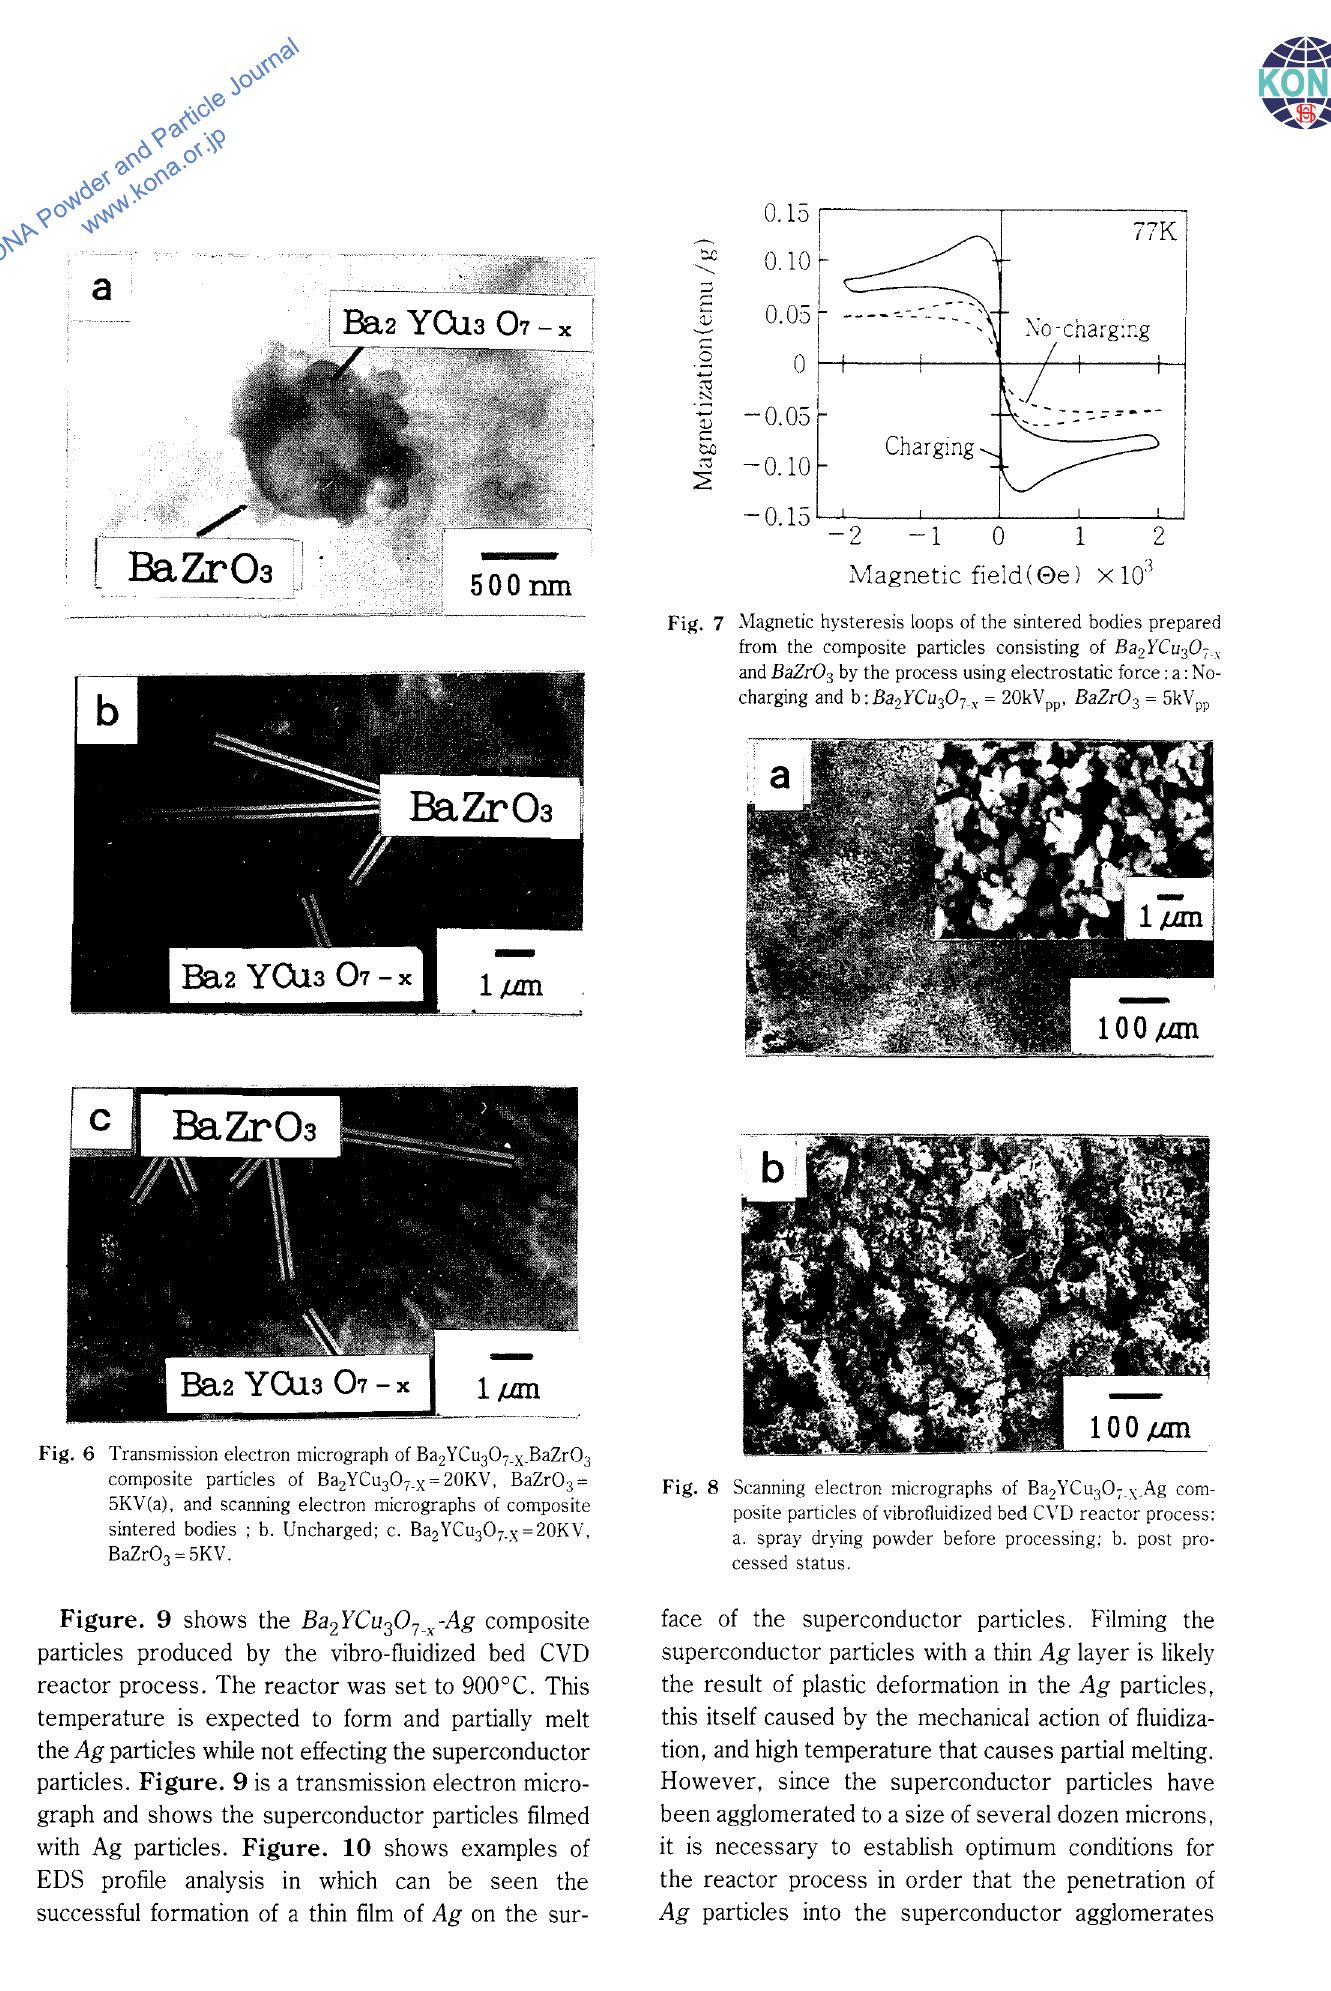
Fig. 6 Transmission electron micrograph of Ba 2 YCu 3 0 7 _x_BaZr0 composite particles of Ba 2 YCu 3 07-X=20KV, BaZr0 5KV(a), and scanning electron micrographs of composite sintered bodies ; b. Uncharged; c. Ba 2 YCu 3 07-X = 20KV, BaZr0 3 = 5KV.